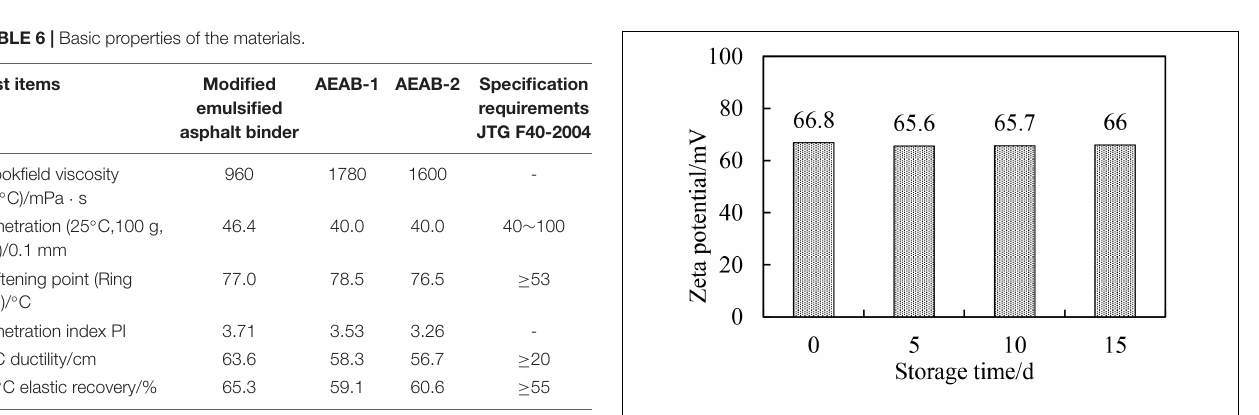
FIGURE 4 | Zeta potential of modified emulsified asphalt binder at different storage